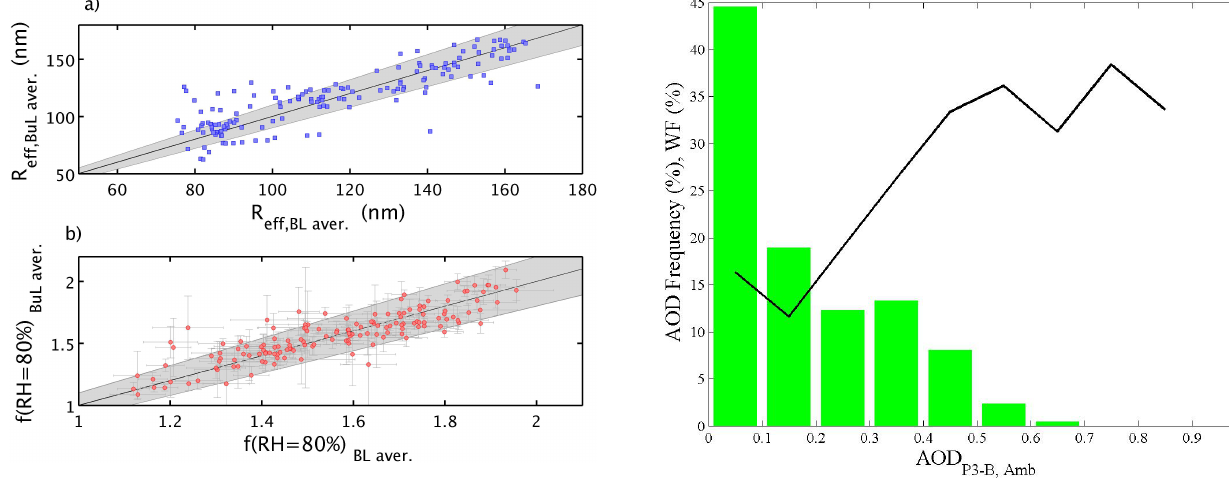
Fig. 8. Comparison of the effective radius (a) and f (RH = 80) 550 nm (b) averaged within the BL (boundary layer) and the BuL (buffer layer) for all the DISCOVER-AQ sites (Beltsville, Padonia, Fairhill, Aldino, Edgewood and Essex). The black line corresponds to the 1 : 1 line and the gray area represents the 10% variability.